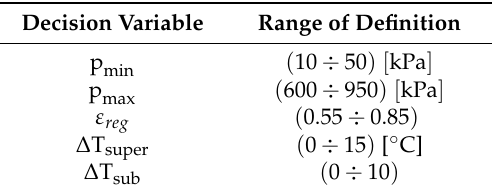
Table 2. Range of definition for the decision